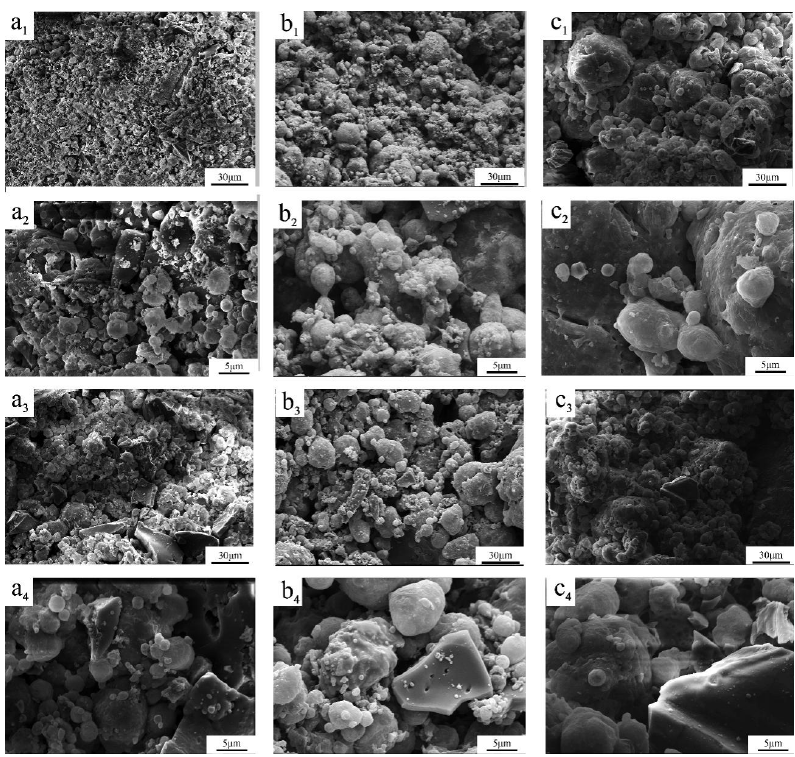
Figure 10. SEM images of char residue on surface and surface pores after cone calorimeter test with different magnification: ( a 1 –a 4 ) BC/PLA/AHP (25/55/20), ( b 1 –b 4 ) BC/PLA/AHP (25/50/25), and ( c 1 –c 4 ) BC/PLA/AHP (25/45/30).